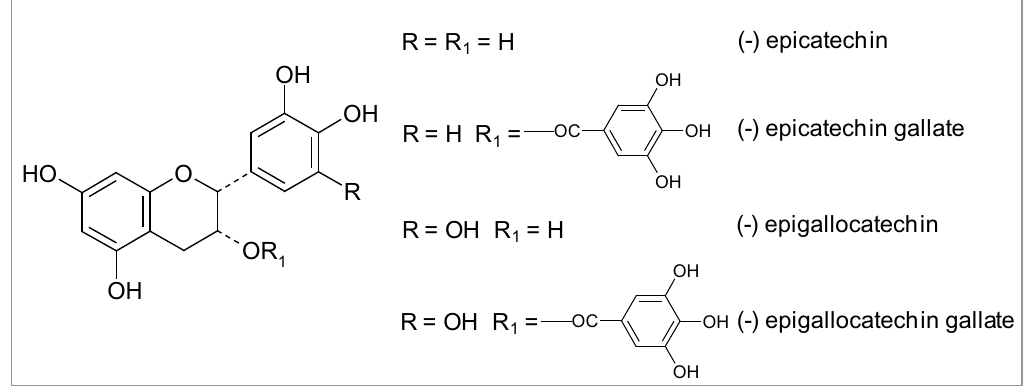
Figure 16. C hemical structures of major